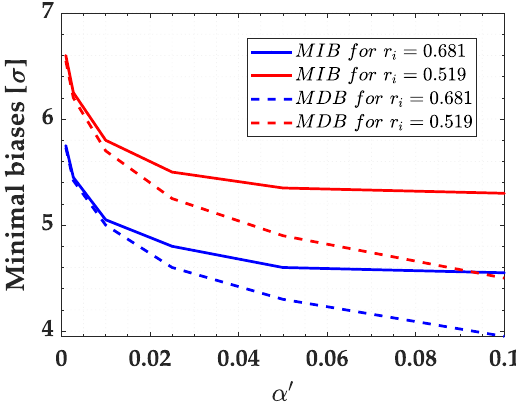
Figure 9. Minimal Detectable Bias (MDB) and Minimal Identifiable Bias (MIB) for both external and internal connections and for each α (cid:48)